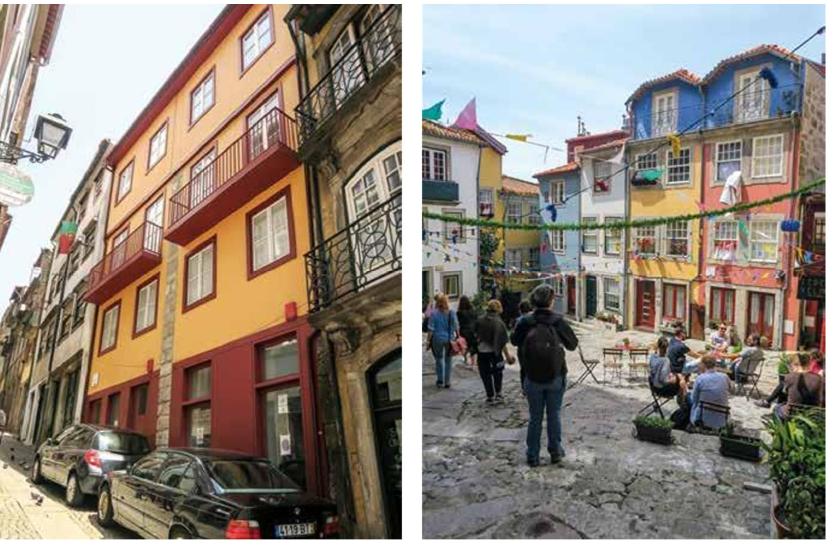
Figure 13. In Porto, old houses that were renovated and offered as holiday flats to visitors [3].